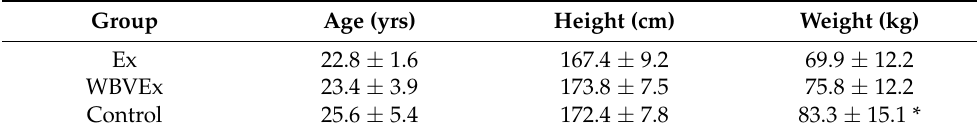
Table 1 Legend: All data are presented as means ± standard deviation. Abbreviations: years old (yrs), centimeters (cm), kilograms (kg), whole body vibration and core exercise group (WBVEx), exercise group (Ex), * significant difference between weight of the Ex and control group ( p < 0.05).